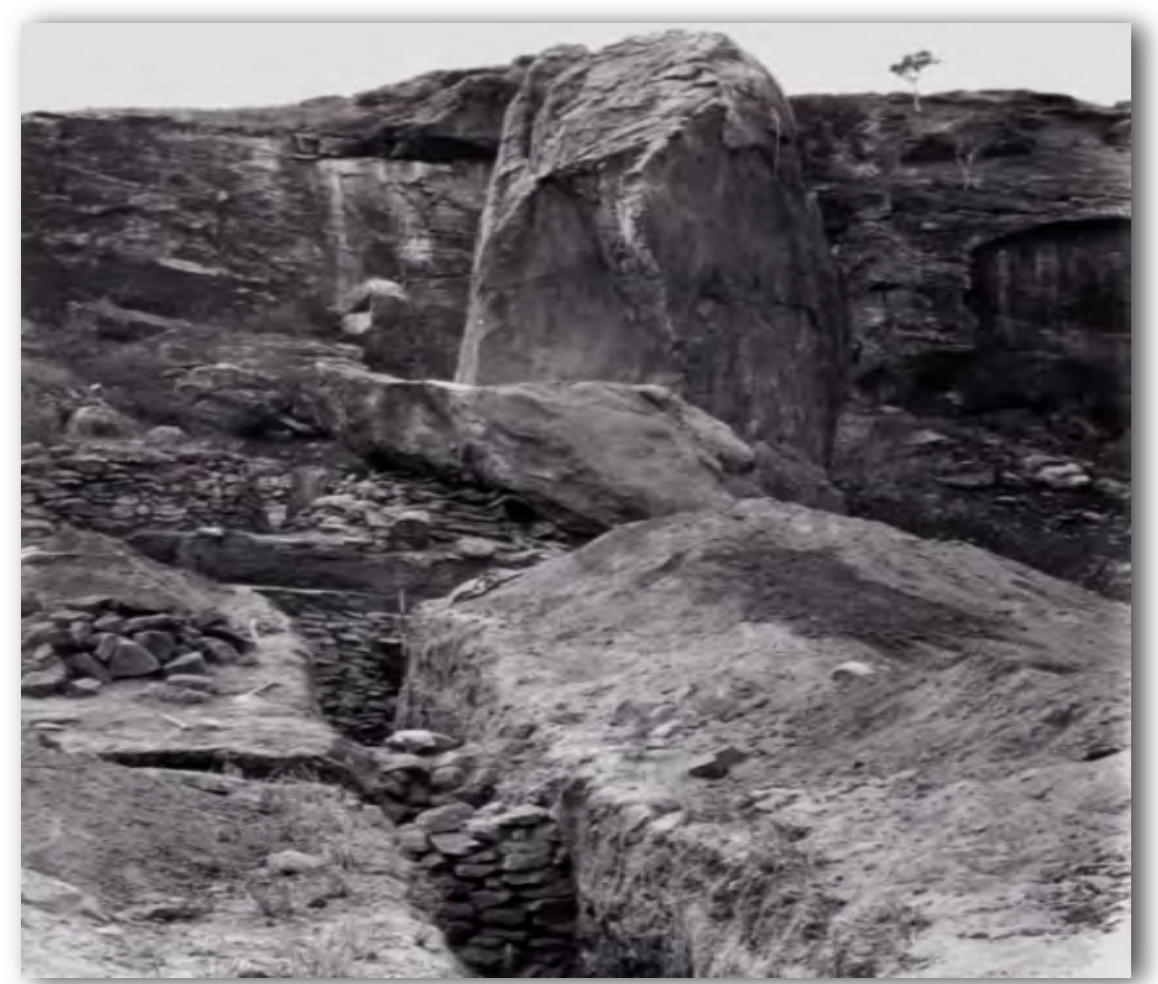
Figure 3. A series of terrace stonewalls on the Southern Terrace at Mapungubwe, exposed during the excavations of 1934 (Fouché 1937:Plate